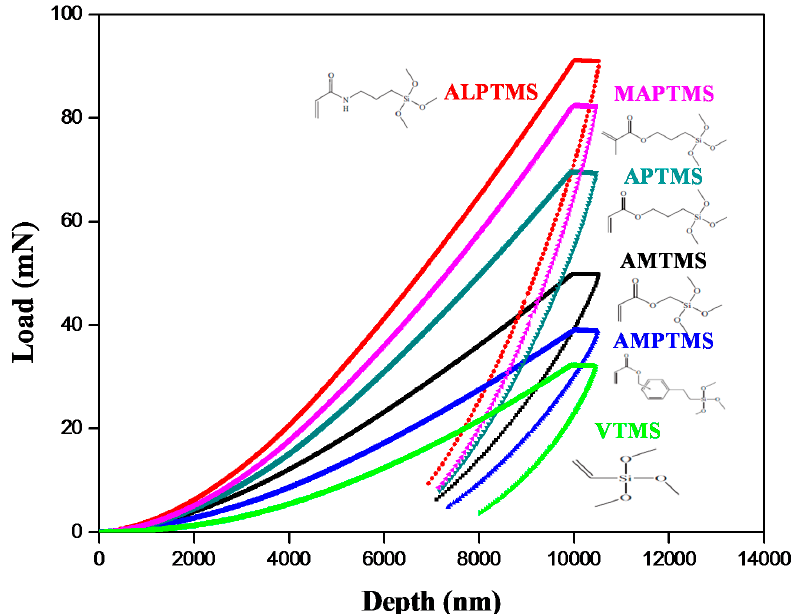
Figure 8. Load-depth curves of the 3D-printed objects printed using the SCA-coated Al 2 O 3 /High-temp composite solutions with different organofunctional groups measured by nanoindentation. Table 1. Hardness and elastic modulus values of the 3D-printed objects printed using the SCA-coated Al 2 O 3 /High-temp composite solutions with different organofunctional groups.